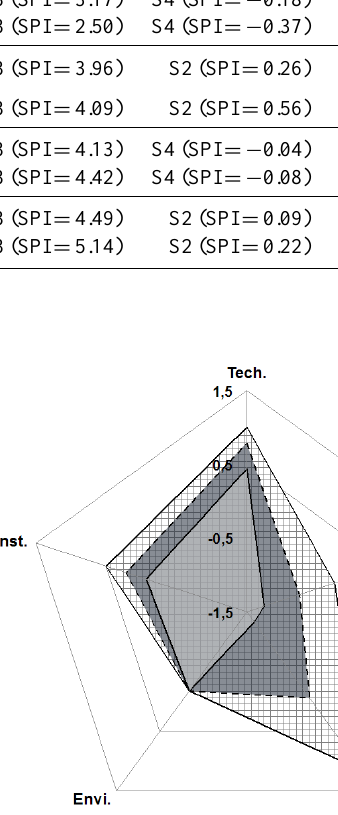
Figure 5. Sustainability profile of S4 under uncertainty (source: au-